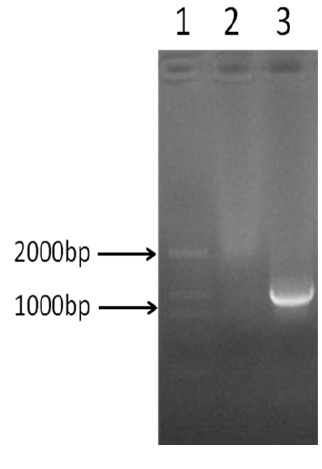
Figure 1. Electrophoresis of GLT8D2 PCR product on 1% agarose gel. Lane 1 : DNA marker; Lane 2 : Negative control; Lane 3 : amplified GLT8D2 gene (1050